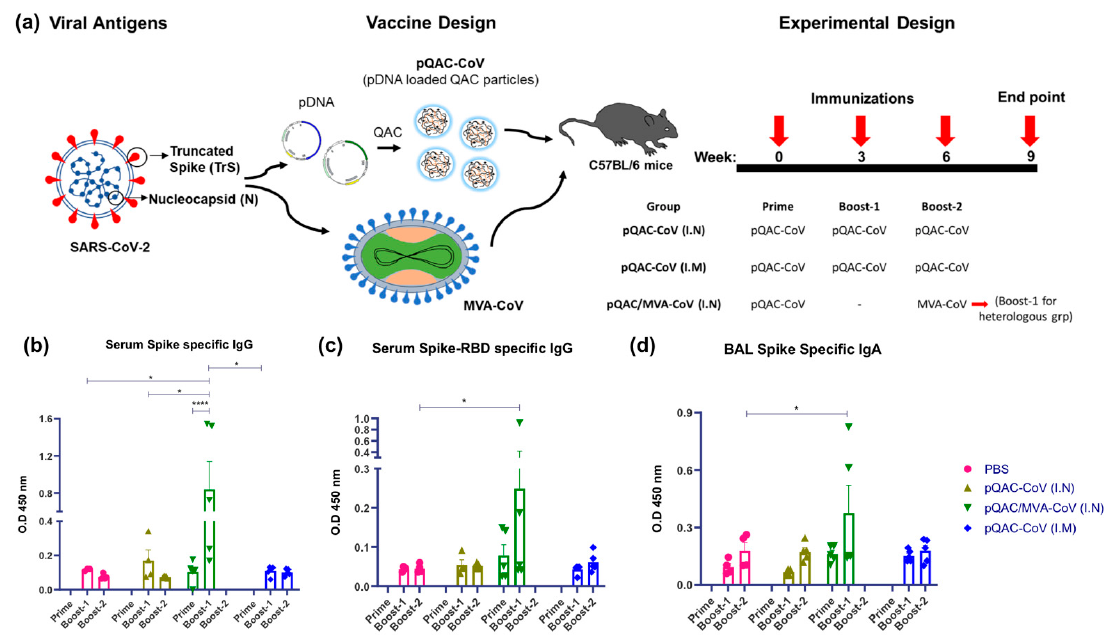
Figure 2. Generation of humoral immune responses in C57BL/6 mice following immunization with different vaccine constructs. ( a ) Outline for vaccine construct and immunization protocol using groups of C57BL/6 mice vaccinated with 3 doses of pQAC-CoV (I.N) or pQAC-CoV (I.M) with 3-week interval. Another group of C57BL/5 mice were vaccinated with pQAC- CoV (I.N) at week-0 followed by boost with MVA-CoV (I.N) at week-6. ( b ) ELISA titers of SARS-CoV-2 S-specific IgG in mice sera, ( c ) ELISA titers of SARS-CoV-2 spike receptor-binding domain (RBD)-specific IgG in mice serum and ( d ) ELISA titers of SARS-CoV-2 S-specific IgA in bronchoalveolar lavage (BAL), significance (*, p < 0.05, ****, p < 0.0001) was determined by two-way ANOVA. Data show mean ± SEM.